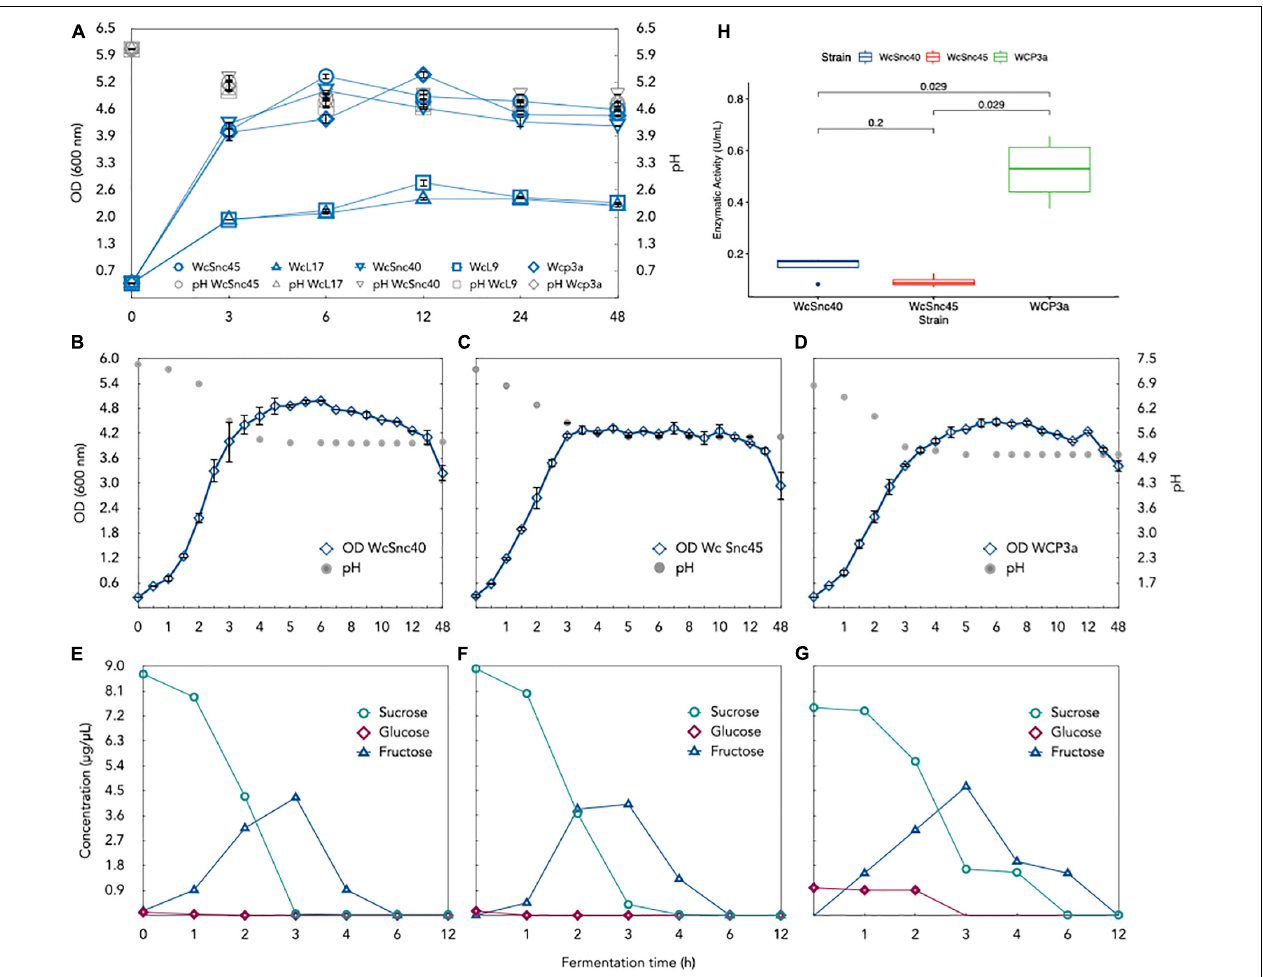
FIGURE 3 | Culture of five Weissella strains isolated from pozol in MRS-sucrose medium. (A) Biomass evolution (OD) of the five strains. The three strains with the highest growth, namely (B) WcSnc40, (C) WcSnc45, and (D) WCP3a, were studied in terms of growth (OD) and evolution of pH. Metabolized sucrose, glucose, and fructose were also monitored by HPLC analysis in the three Weissella cultures: strains (E) WcSnc40, (F) WcSnc45, and (G) WCP3a. Finally, extracellular glycosyltransferase activity (U/mL) for the three strains in 6-h cultures was compared (H) ; statistically significant differences in activity ( p < 0.5) were obtained with the ggpubr package in R